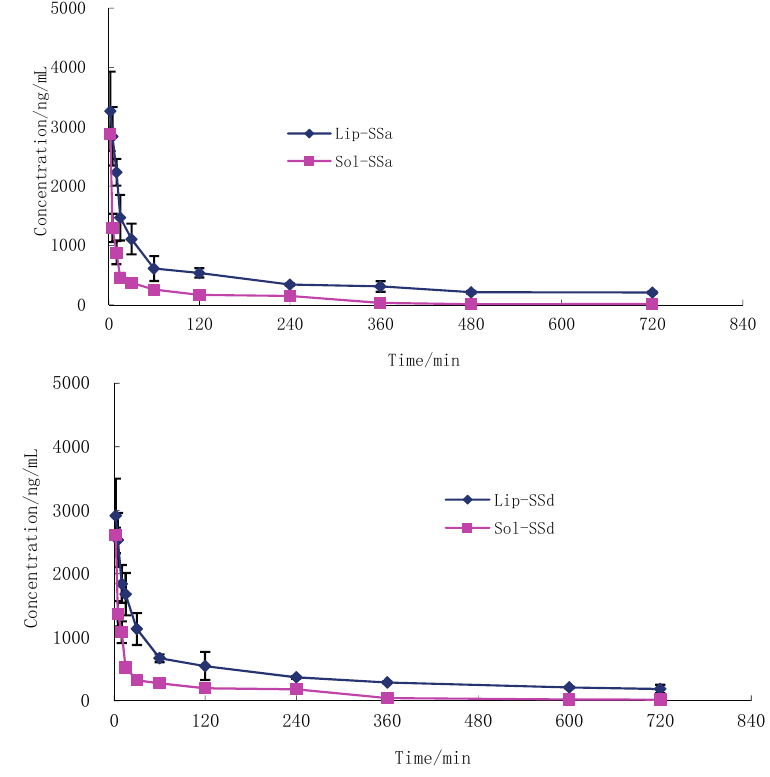
Figure 5. Mean concentration–time profile of SSa ( A ) and SSd ( B ) in rat plasma after a single intravenous administration of SSa-SSd-Lip (SSa 1 mg/kg, SSd 1 mg/kg, n = 6) and